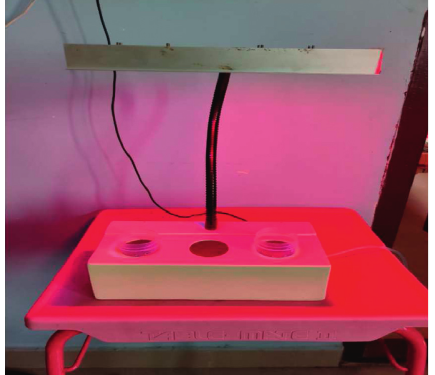
Figure 28: LED system with red (660 nm and 730nm) LED ON.